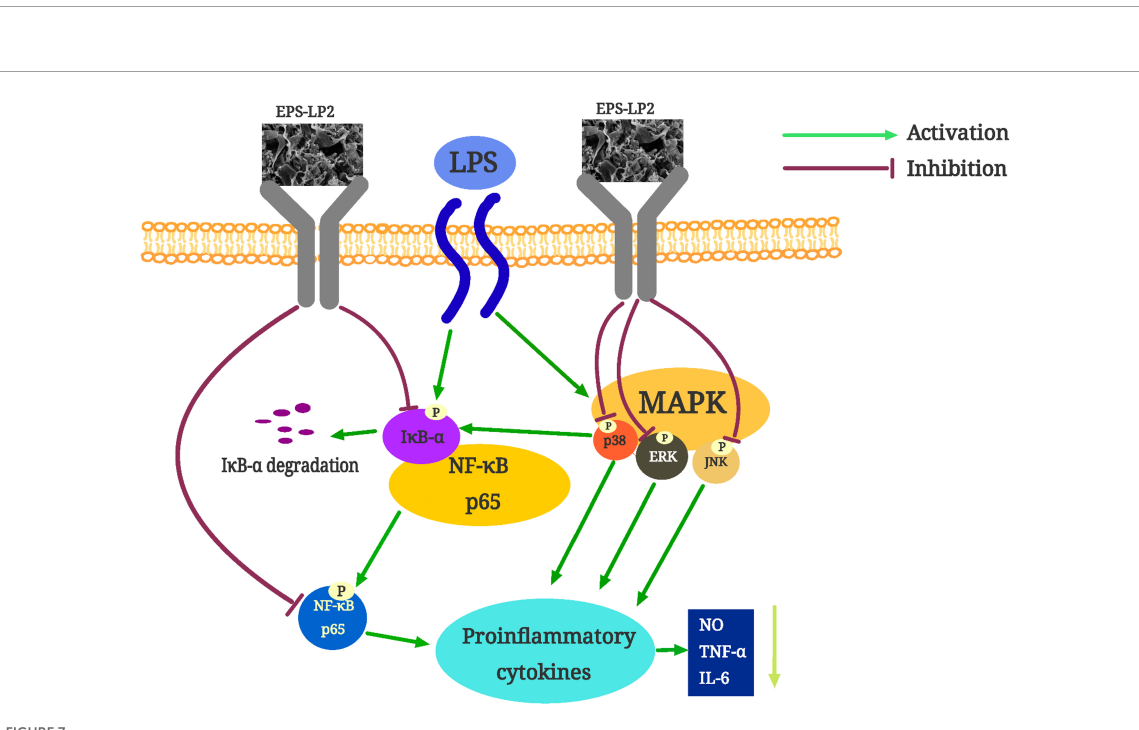
FIGURE7 The possible mechanism of exopolysaccharides (EPS)-LP2 inhibiting inflammation in RAW 264.7